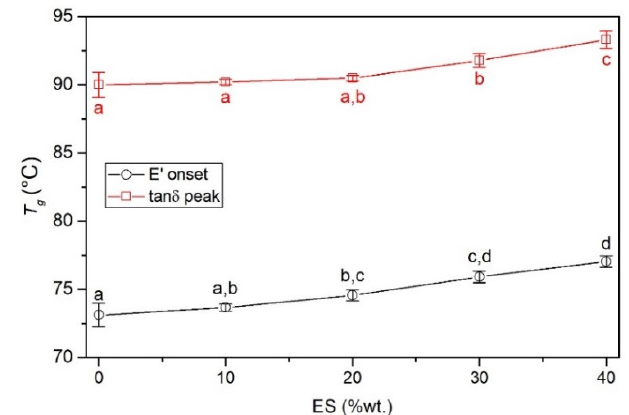
Figure 9. Glass transition ( T g ) vs. content of ES filler.